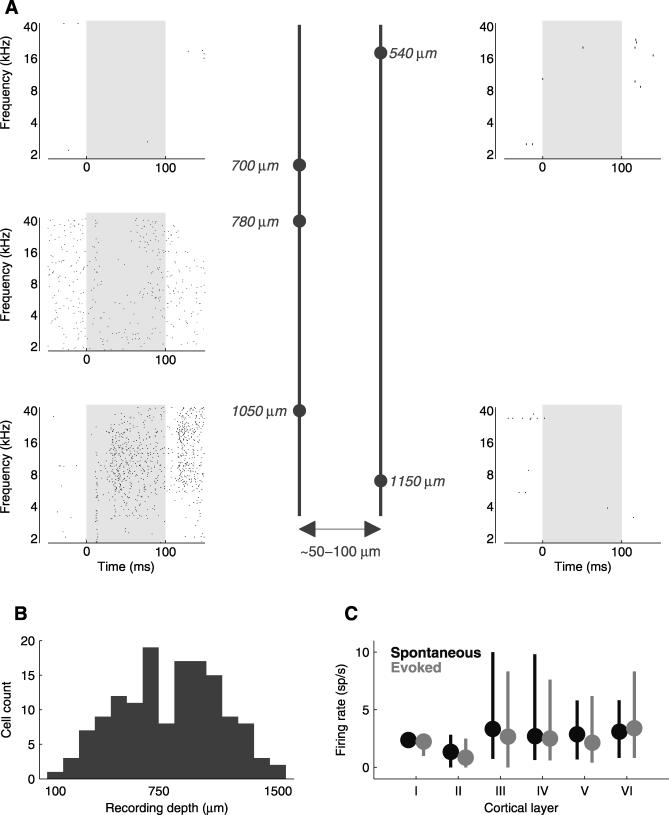
Neither Spatial nor Laminar Position Predicts Response Pattern(A) Neurons recorded in a single penetration can show very different tone-evoked responses. Response rasters are shown from neurons recorded in two penetrations (left and right columns); the penetration depicted in the right column was about 50–100 μm ventrocaudal from the penetration depicted on the left. Dots represent individual spikes and gray shaded regions indicate the tone duration (60 dB, 100 ms). Depths of recordings were measured perpendicular to the cortical surface, as given by micromanipulator readings and as such are approximate. The cell shown in the lower left corner is the same as that in Figure 2B.(B) Frequency histogram of recording depths shows that all depths were represented in our sample. All depths (n = 141 cells) were given by the micromanipulator reading, and as such are only approximate. For four cells the depth information was not available, and they are not included in the figure.(C) Firing rates were similar across cortical layers. Neurons (n = 141) were segregated into six groups corresponding to cortical layers (see text for details). Spontaneous firing rates were computed for each response bin. Evoked firing rates were computed in all evoked response bins. Circles show the positions of medians, error bars extend from the lower quartile (25th percentile) to the upper quartile (75th percentile).